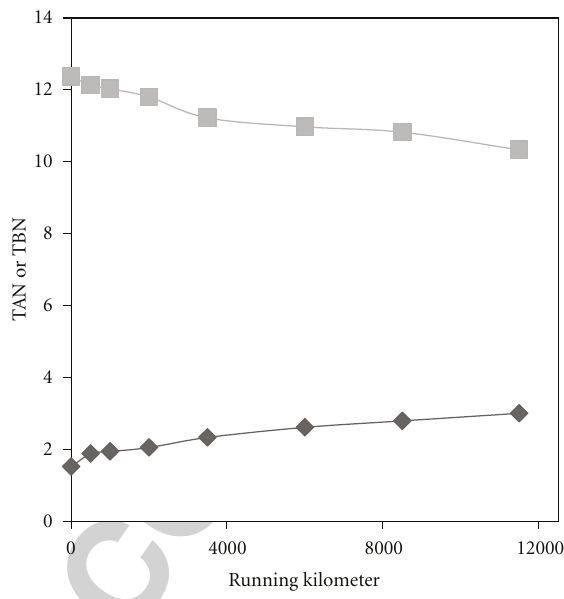
Figure 2: Plots of TAN (bottom) or TBN (top) versus running